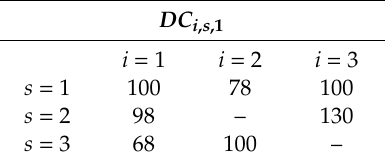
Table A11. Maximum distribution capacity at time period 1